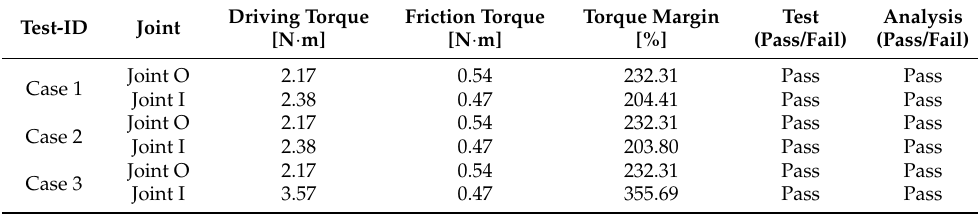
Table 11. Torque margin calculation for all test